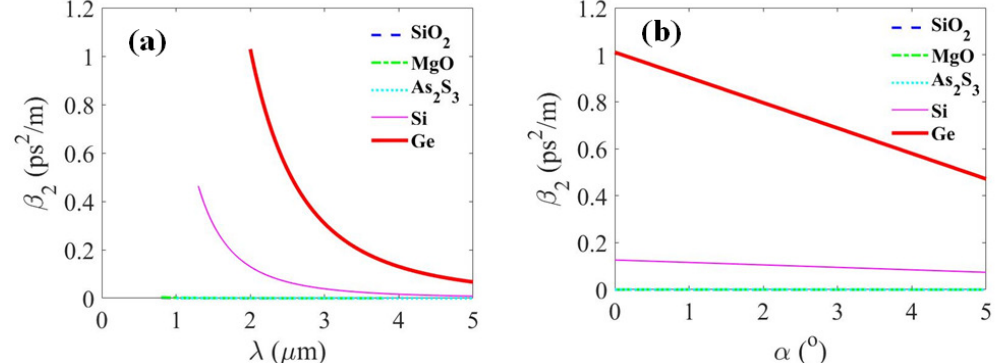
Figure 3. Second-order dispersion coefficients of typical infrared materials: ( a ) Varying with wavelength ( α = 0.5 ◦ ); and ( b ) varying with propagation angle ( λ = 2.05 µ m). The blue dashed line, green dash-dotted line, cyan dotted line, pink thin solid line, and red thick solid line represent the optical materials SiO 2 , MgO, As 2 S 3 , Si, and Ge,